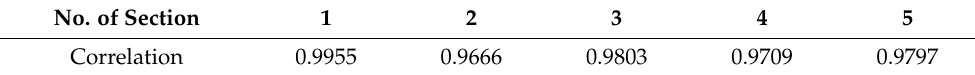
Table 3. Comparison of acoustical aging of SMA 11S and EACC 8 surfaces on selected five sections. No. of Section